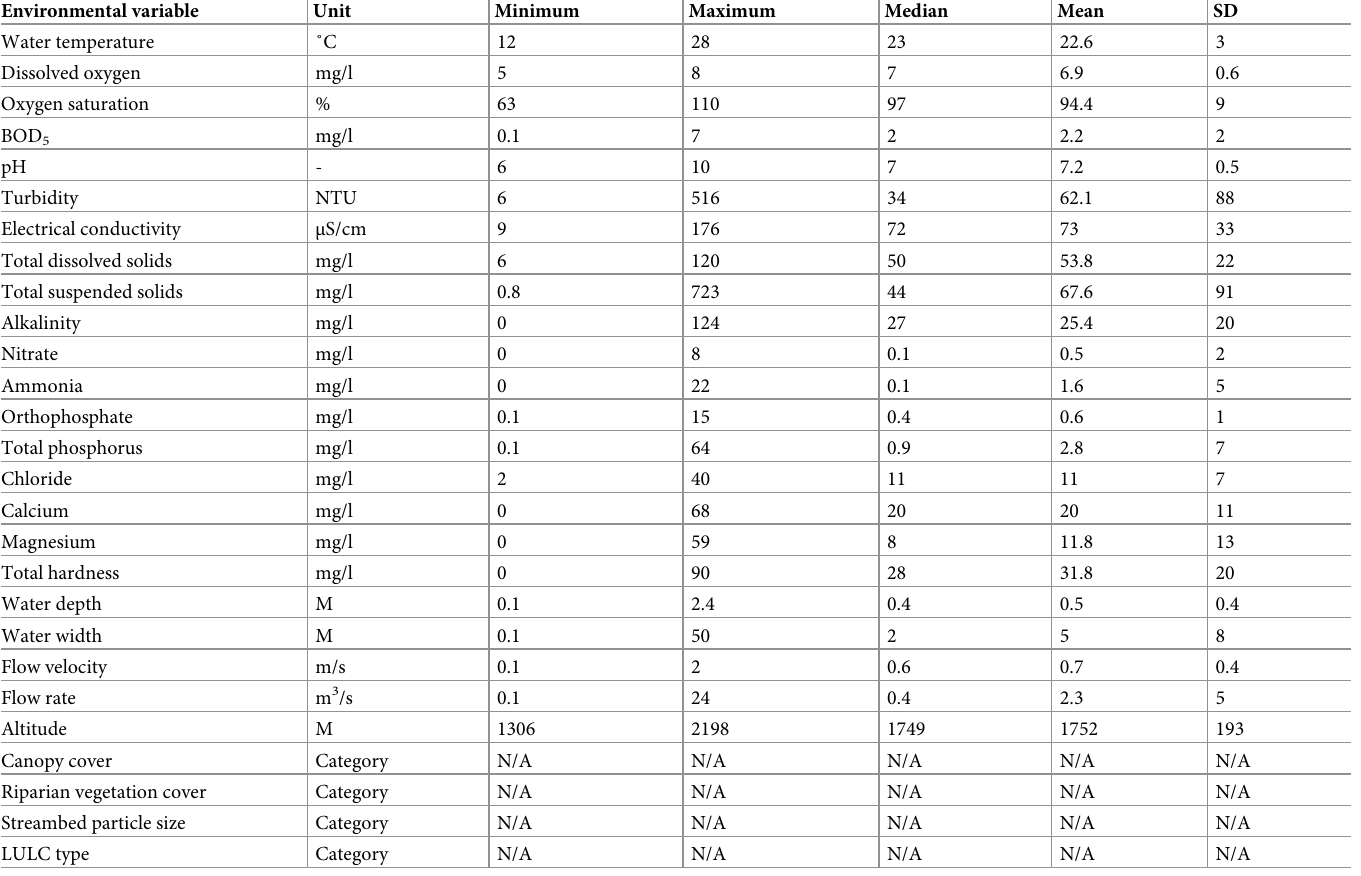
Table 1. Descriptive statistics of environmental variables used to determine the habitat preference of S . damnosum larvae in the Omo Giber river basin, southwest Ethiopia. Environmental variable